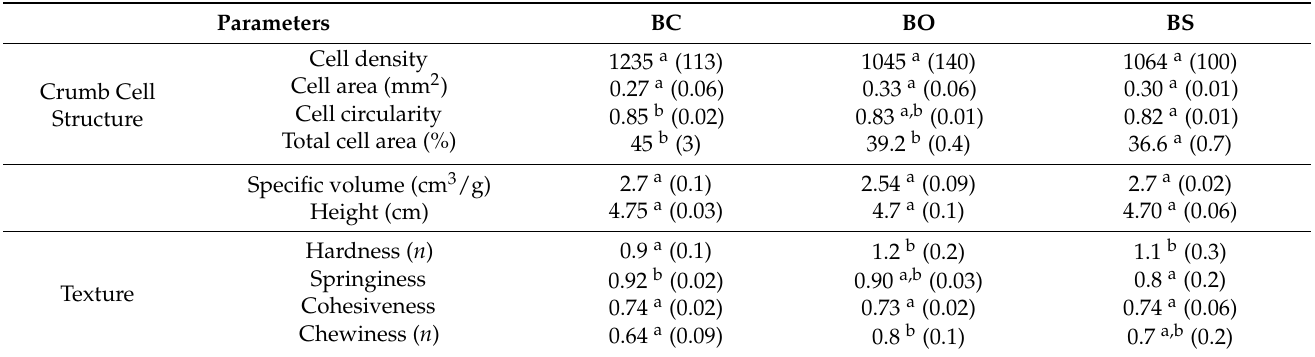
Table 1. Physical properties of baked